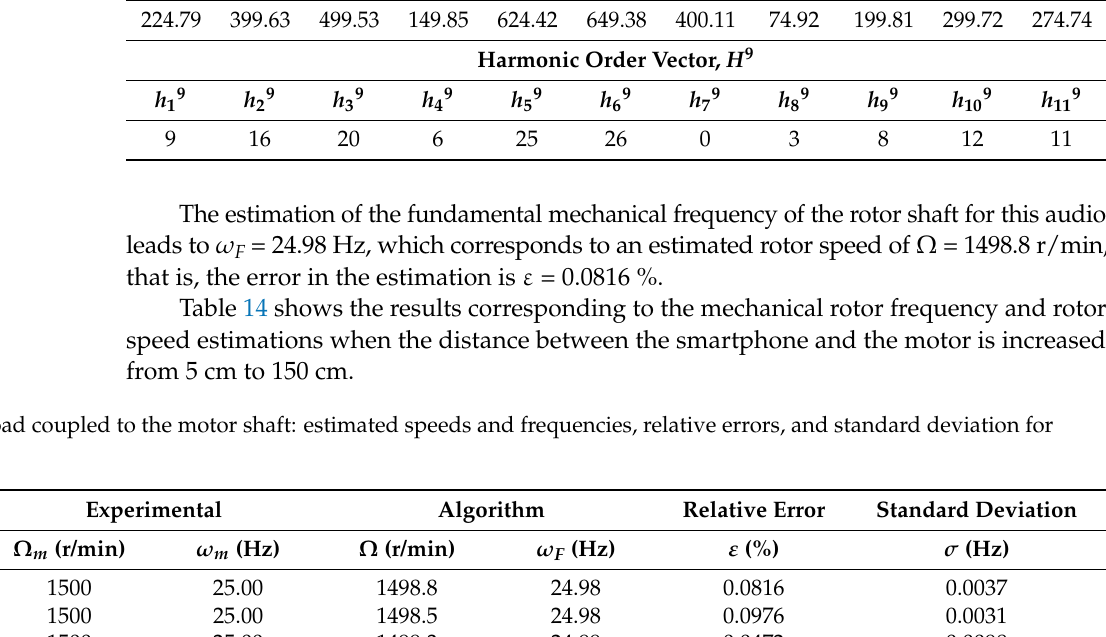
Table 13. No load coupled to the motor shaft: first 11-highest harmonics and their respective order.